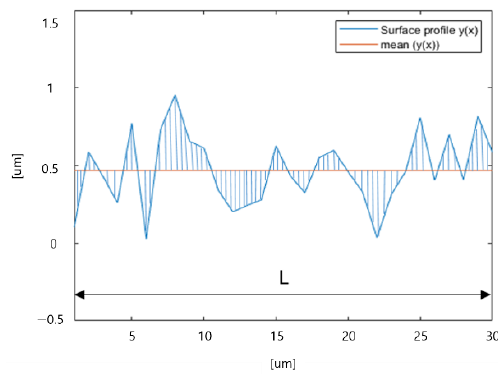
Figure 2. Calculation of surface roughness using surface profile.